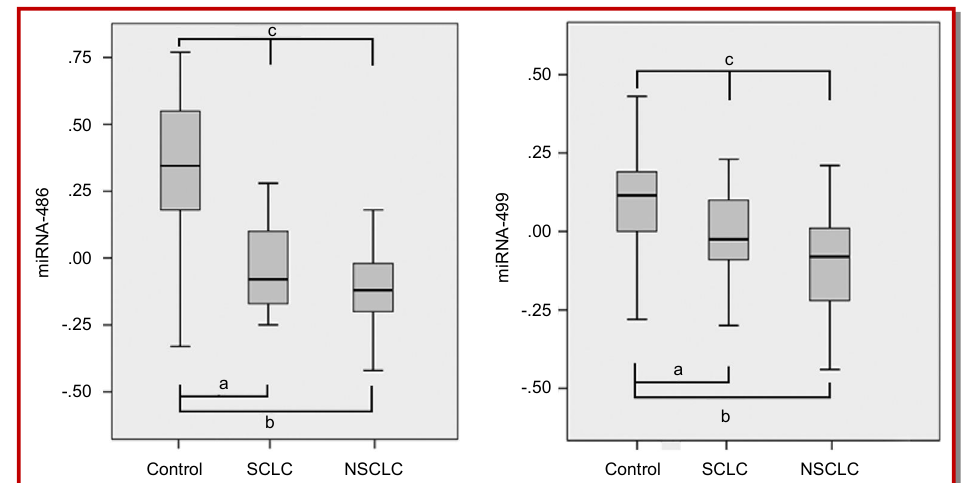
Figure 1: The expression of miR-486 and miR-499 of control group, SCLC and NSCLC. miRNA-486 was down-regulated in SCLC ( a p<0.01) and the decrease is more obviously NSCLC ( b p<0.01). There were significant differences among the three groups ( c H = 28.712, p<0.001). The level of miR486 in SCLC rank above it in NSCLC (p<0.05). miRNA-489 was down-regulated in SCLC ( a p>0.05) and the decrease is more obviously NSCLC ( b p<0.05). There were significant differences among the three groups. ( c H = 14.256, p = 0.001). The level of miR486 in SCLC rank above it in NSCLC (p<0.05). There was not statistically significant between SCLC with NSCLC (p>0.05)